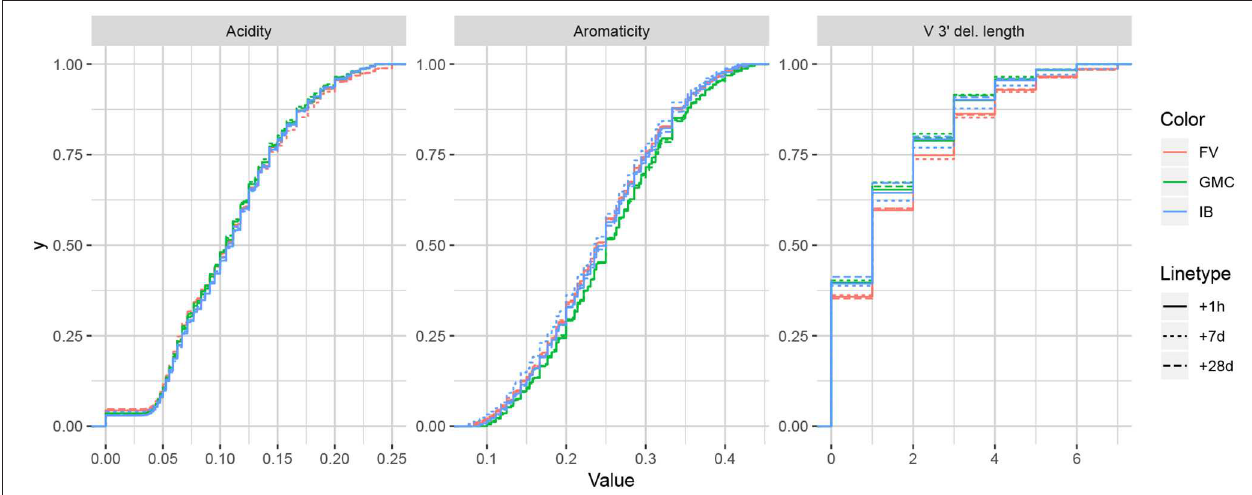
FIGURE 5 | Empirical cumulative distribution functions for the bottom-, middle-, and top-ranked statistics for a validation set of partis -annotated IGH repertoires, as determined by Figure 4B